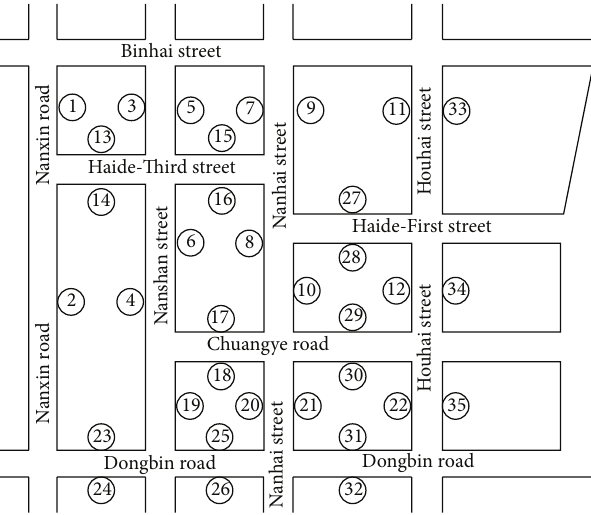
Figure 2: Schematic diagram of Nanshan road network topology.